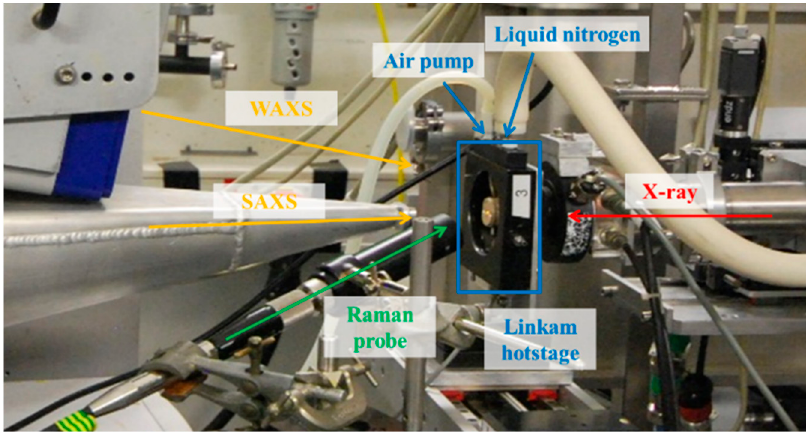
Figure 1. The simultaneous SAXS/WAXS combined with both Linkam DSC and Raman spectroscopy setup at the Dutch-Belgian Beamline (DUBBLE, BM26) at the European Synchrotron Radiation Facility (ESRF).